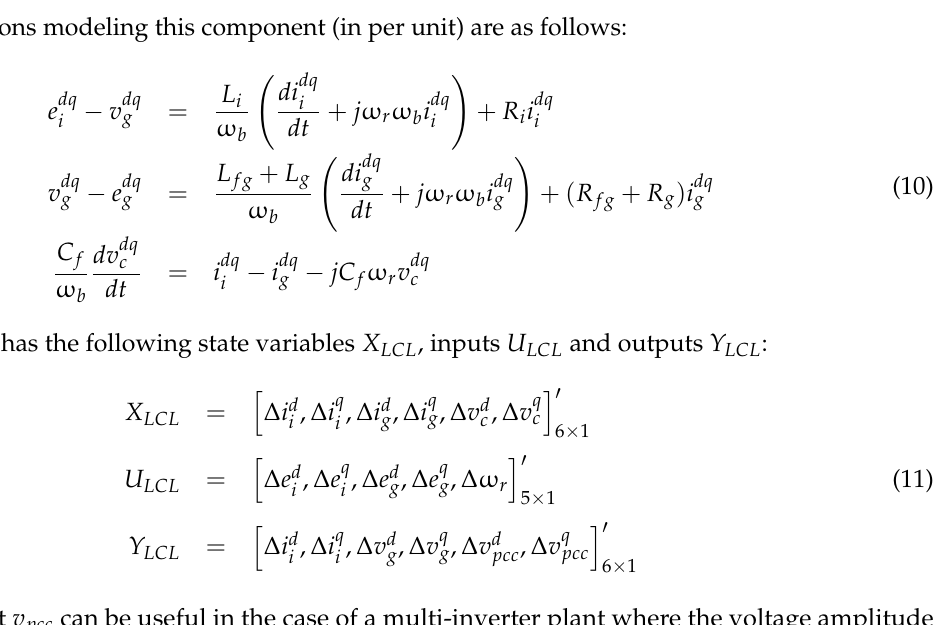
Figure 5. LCL model in the stationary ( α , β ) frame.